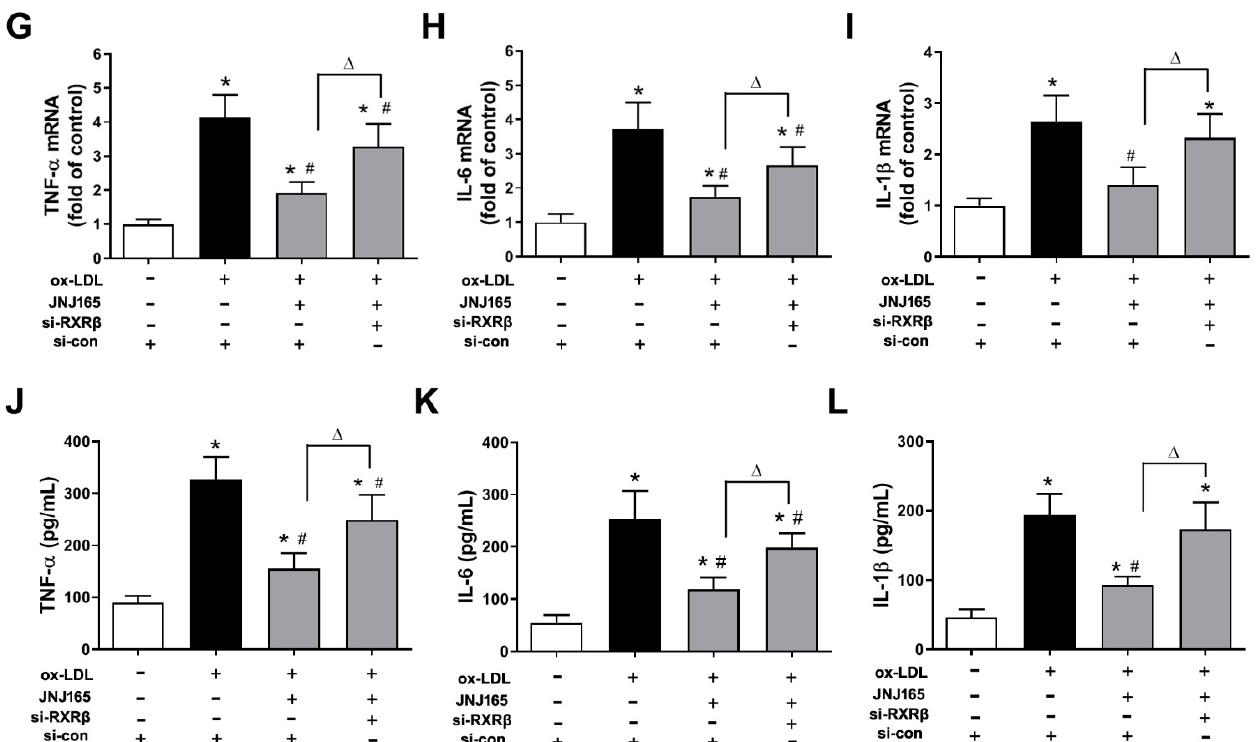
Figure 6. MDM2 inhibitor JNJ-165 provides protection against ox-LDL-induced mitochondrial-related inflammation via RXR β . HAECs were transfected with RXR β siRNA (si-RXR β ) or si-con for 24 h and then treated with or without JNJ-165 (10 μ M). After 1 h, the cells were stimulated with 100 μ g/mL ox-LDL for an additional 24 h. ( A ) The protein expression of TLR9. ( B ) NF- κ B p65 DNA binding activity. ( C ) The protein expression of NLRP3. ( D , E ) The protein expression of caspase-1. ( F ) The level of caspase-1 p20 in culture supernatants. ( G – I ) The mRNA expression of TNF- α ( G ), IL-6 ( H ) and IL-1 β ( I ). ( J – L ) The secretion of TNF- α ( J ), IL-6 ( K ) and IL-1 β ( L ). Results are presented as the mean ± SD. n = 6. * p < 0.05 vs. si-con with no treatment, # p < 0.05 vs. ox-LDL + si-con group, Δ p < 0.05.